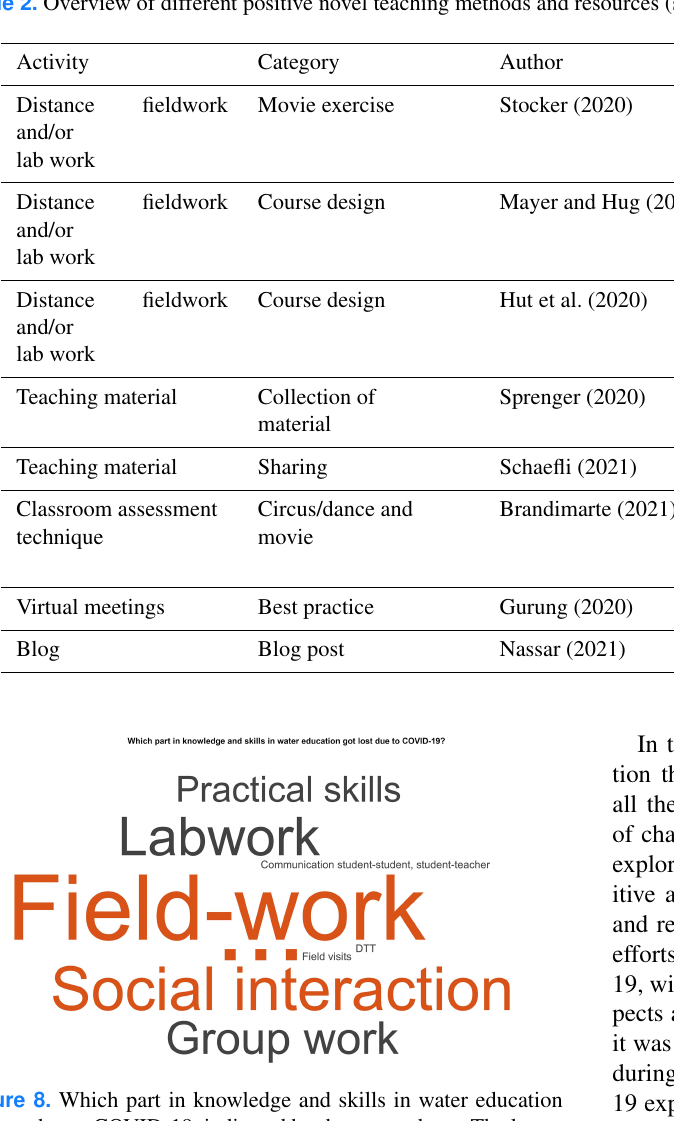
Table 2. Overview of different positive novel teaching methods and resources (see the link in the bibliography for more content).